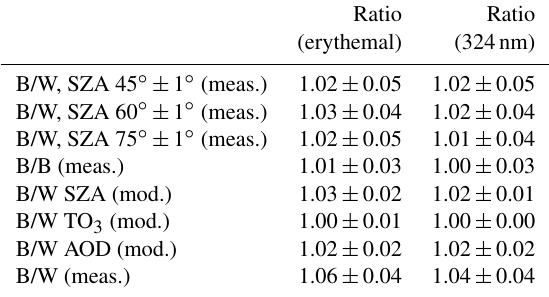
Table 1. Mean ratios and corresponding standard deviations for comparison between UV doses and irradiances (erythemal, UVA – 324nm) modelled (mod.) by libRadtran and measured (meas.) by BSs in Warsaw (W) and Belsk (B) for cloudless-sky con- ditions. B / B is a ratio between doses for BSs intercomparison (BS064 / BS207) at